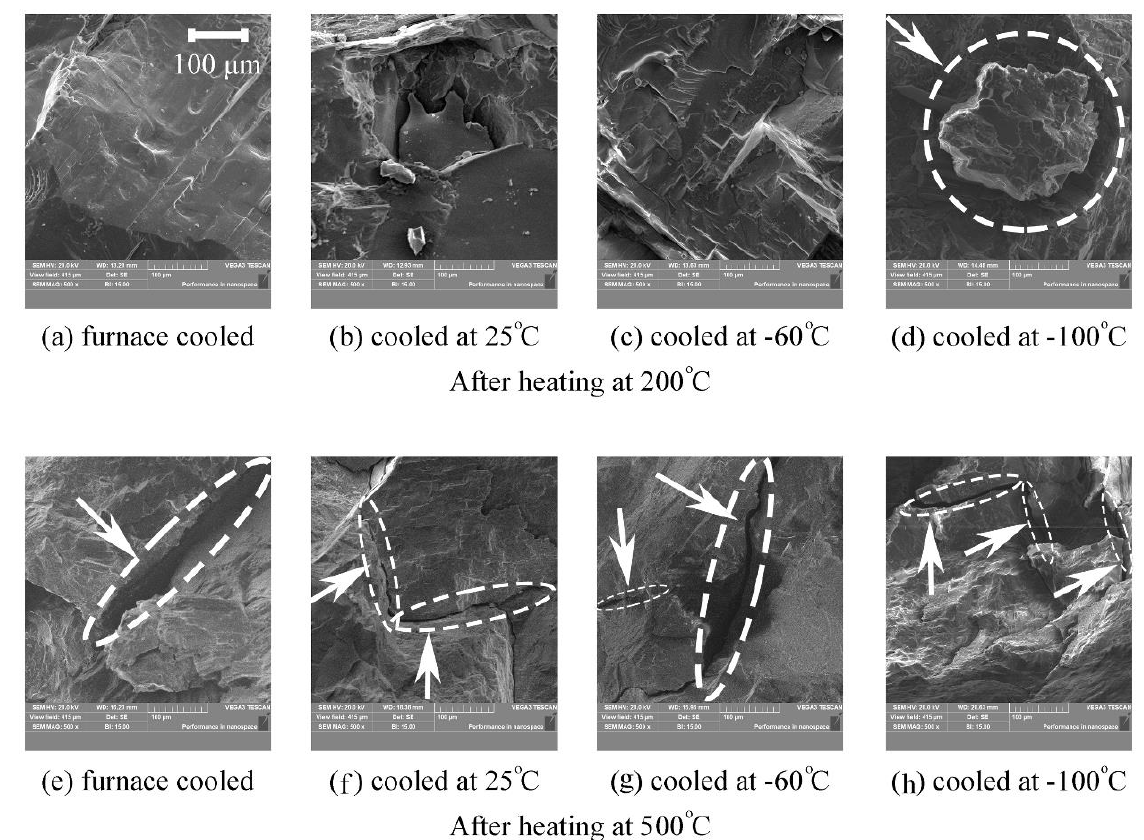
Figure 11. SEM images illustrating fracture surfaces of granite specimens after thermal shock treatments (magnified 500 times).